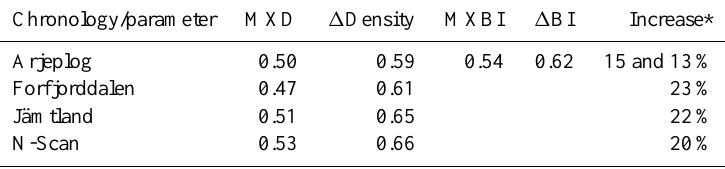
Table 1. Explained variance ( R 2 ) in JJA temperatures from MXD and 1 density as well as MXBI and 1 BI. Temperature data from CRU TS3.1 data set (Harris et al., 2013). All chronology and temperature data are prior to analysis transformed into first differences, to remove positive